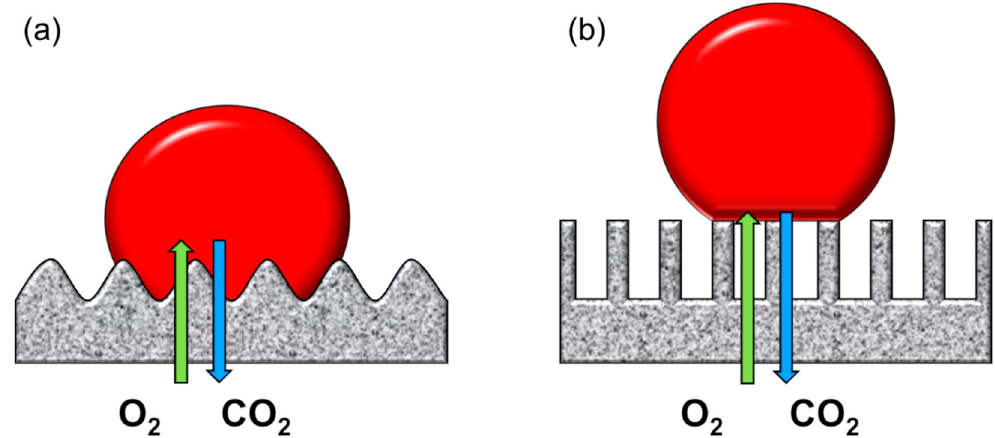
Figure 9. The wettability of blood droplet on the rough surface: (a) Wenzel state, (b) Cassie–Baxter